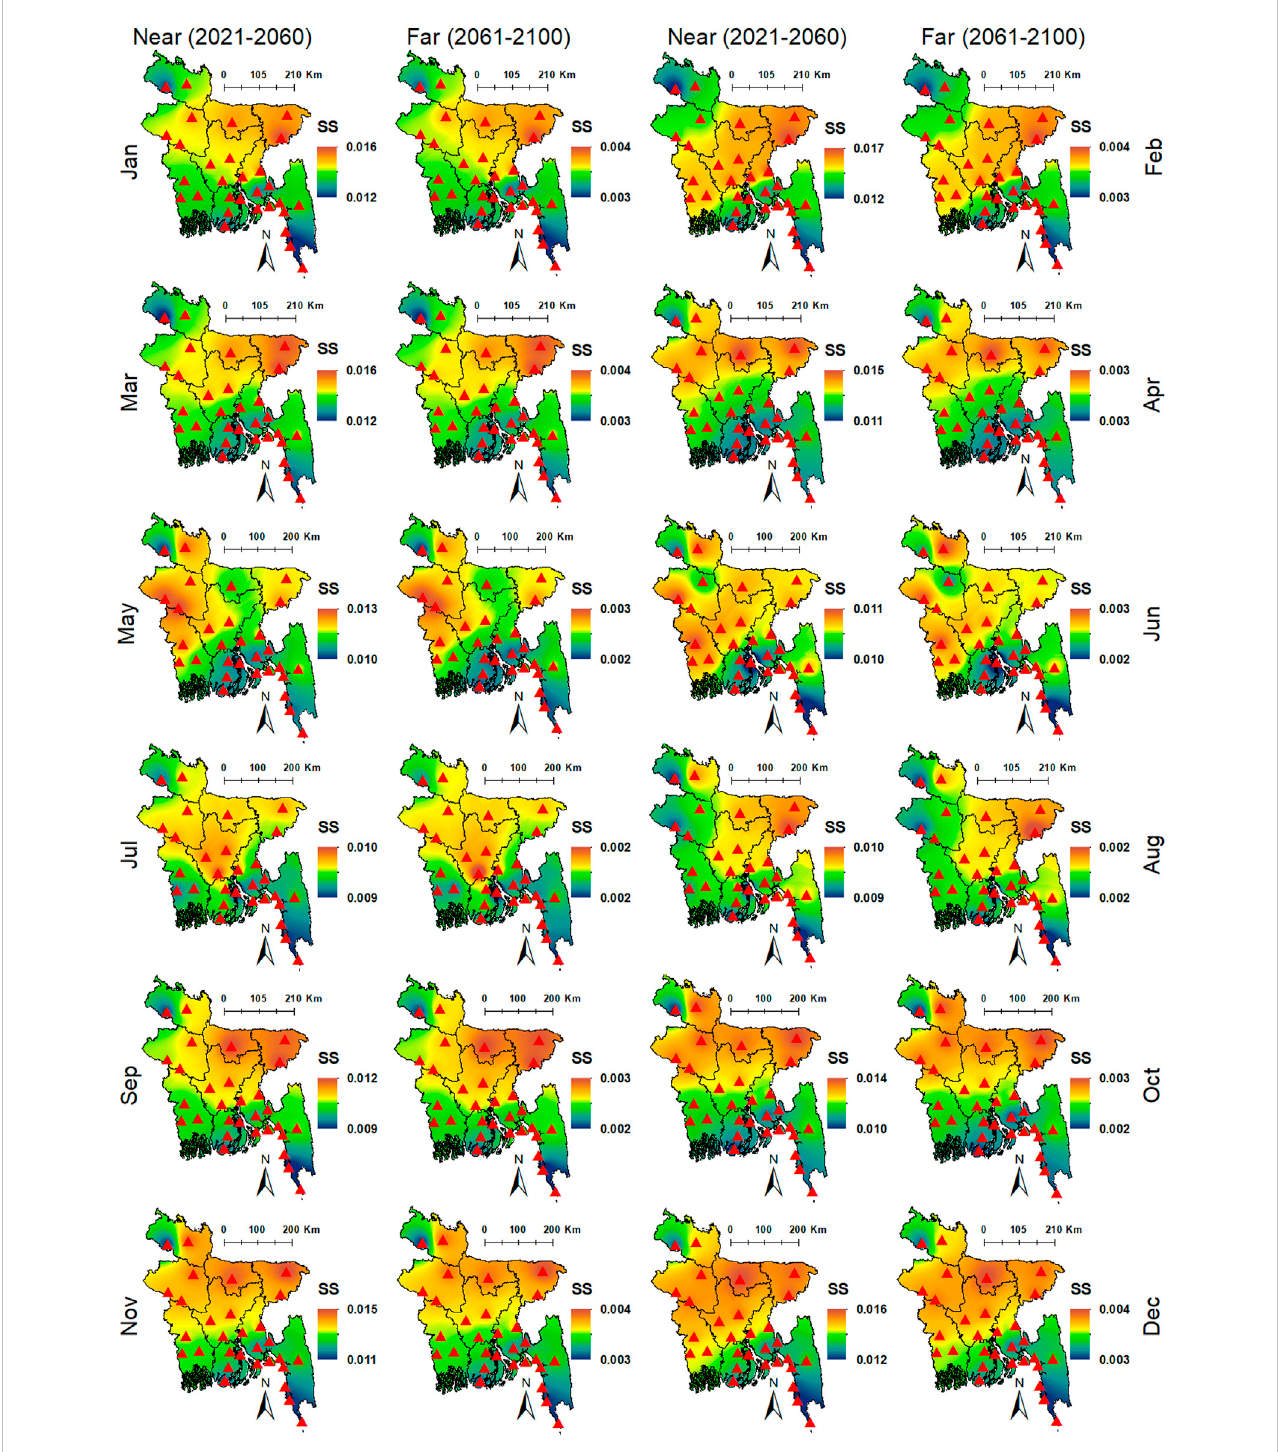
FIGURE 6 Spatial distribution of monthly (Jan-Dec) Tmin (oC) trends (SS) for near (2021 – 2060) and far (2061 – 2100) futures over Bangladesh considering 30 meteorological stations for RCP4.5.